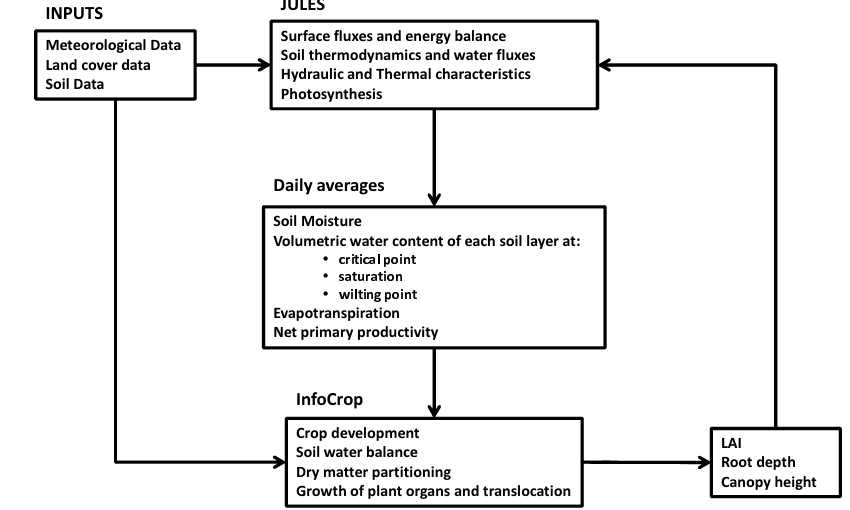
Figure 3. Flow chart of the coupling